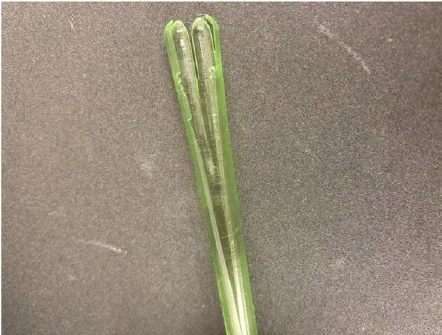
Fig. 8 Cover crack area, with a soft edge